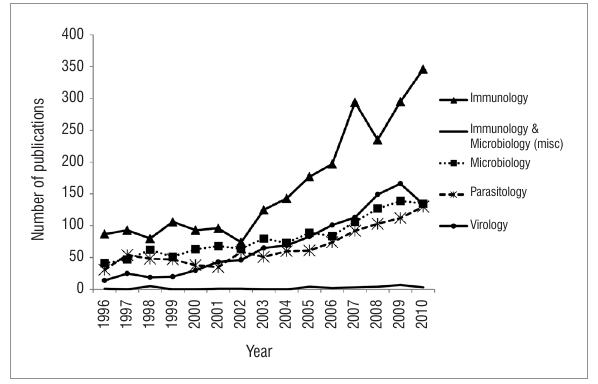
Figure 5: Number of publications from South Africa in the Microbiology/ Immunology disciplines during 1996–2010.